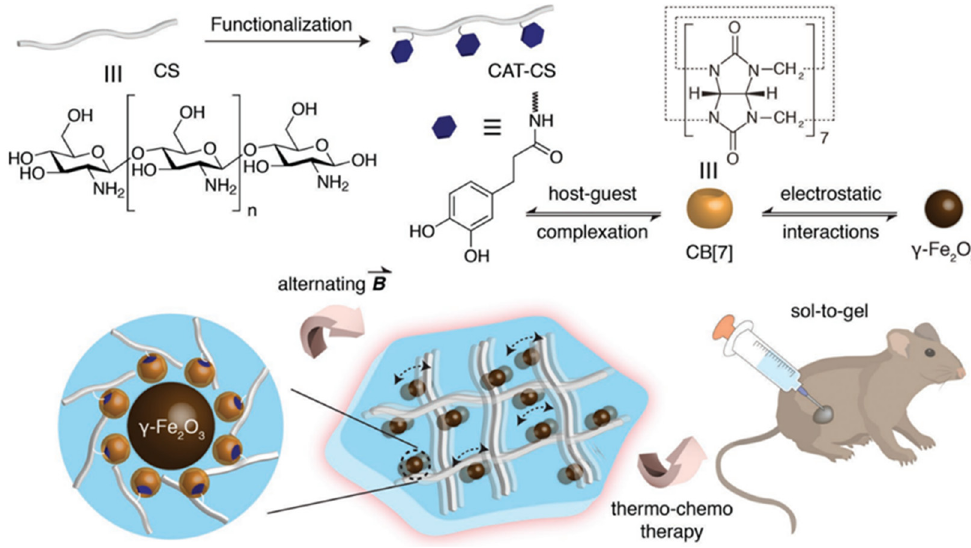
Figure 25. Diagram of magnetic hydrogel nanocomposites made by molecular recognition and elec- trostatic interaction with CB[7] (reproduced with permission of John Wiley & Sons, Inc., from ref. [101]).